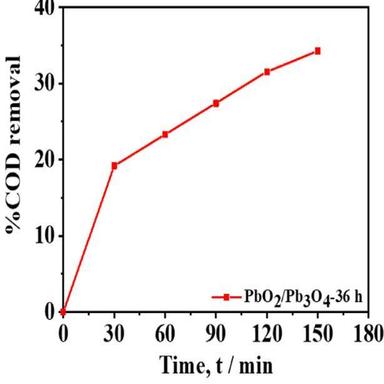
The COD removal ratio under optimized operating conditions using